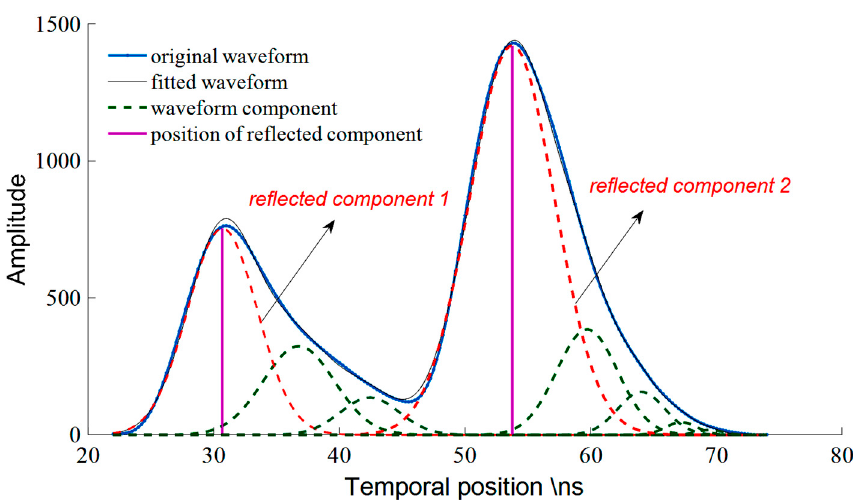
Figure 4. “Tailing” of a waveform with two echoes.